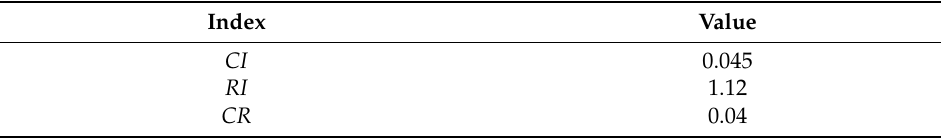
Table 10. Consistency